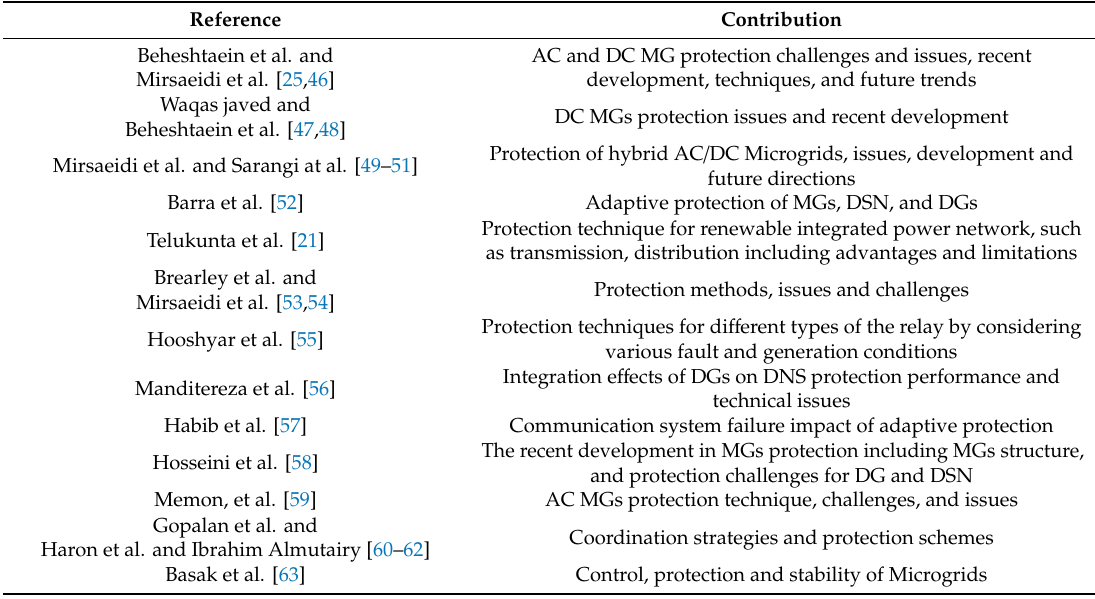
Table 1. Summary of few existing review articles for MG